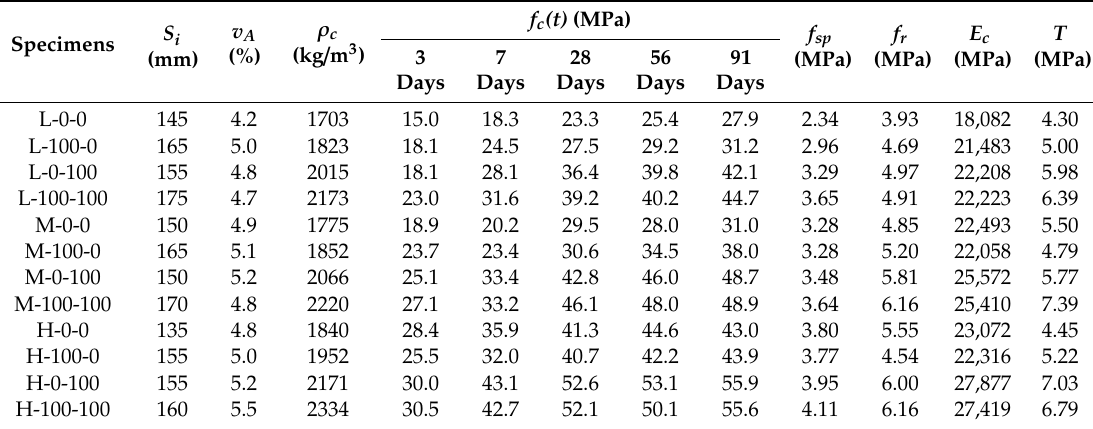
Table 4. Summary of the test results.